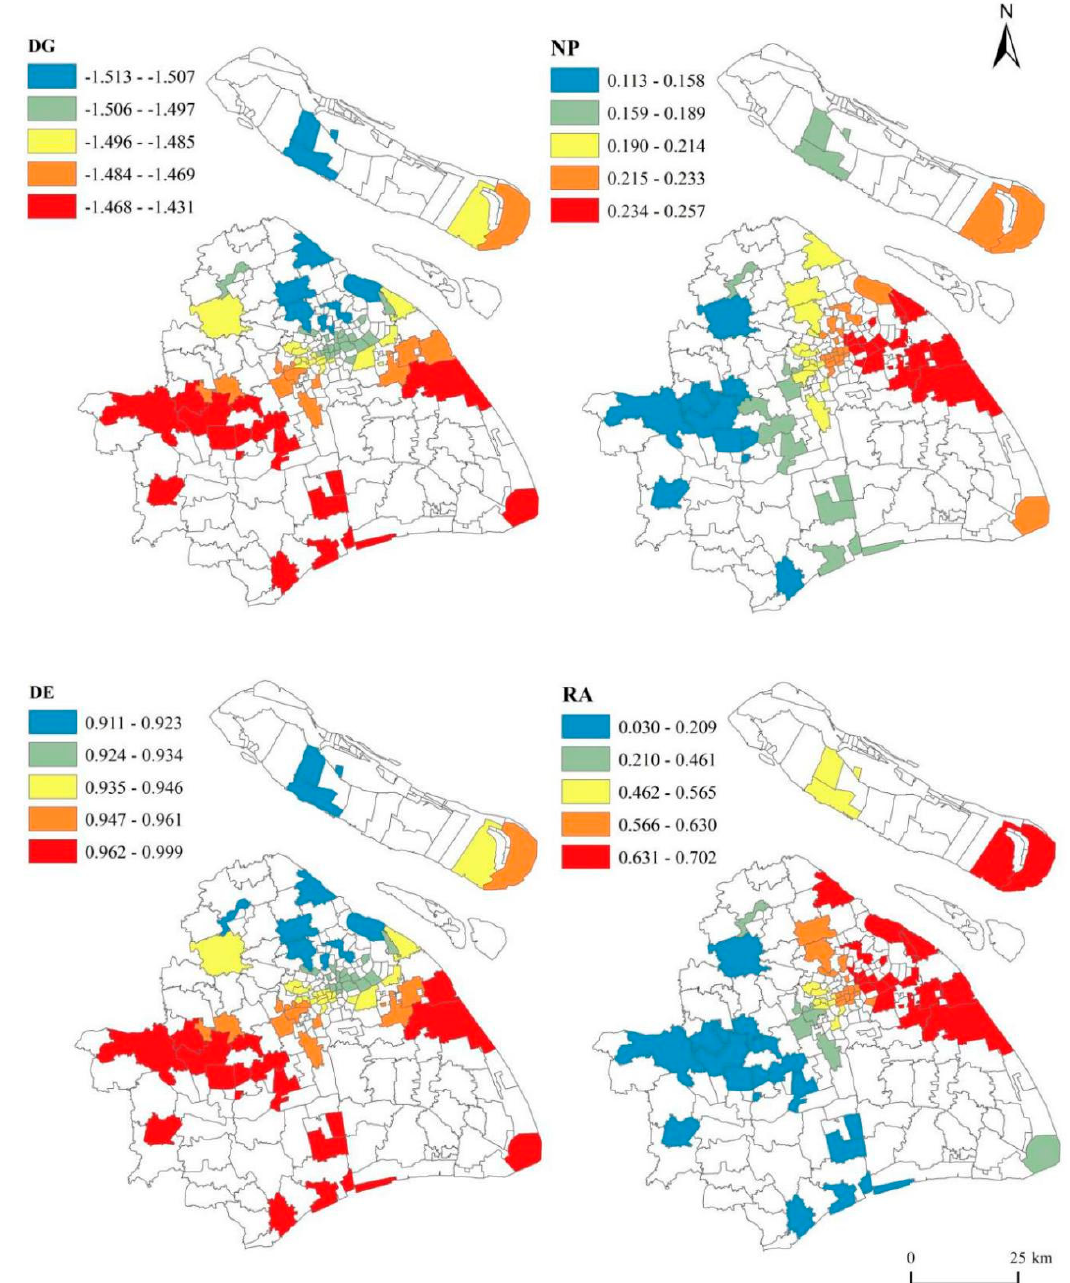
Figure 7. Spatial patterns of estimators of variables.